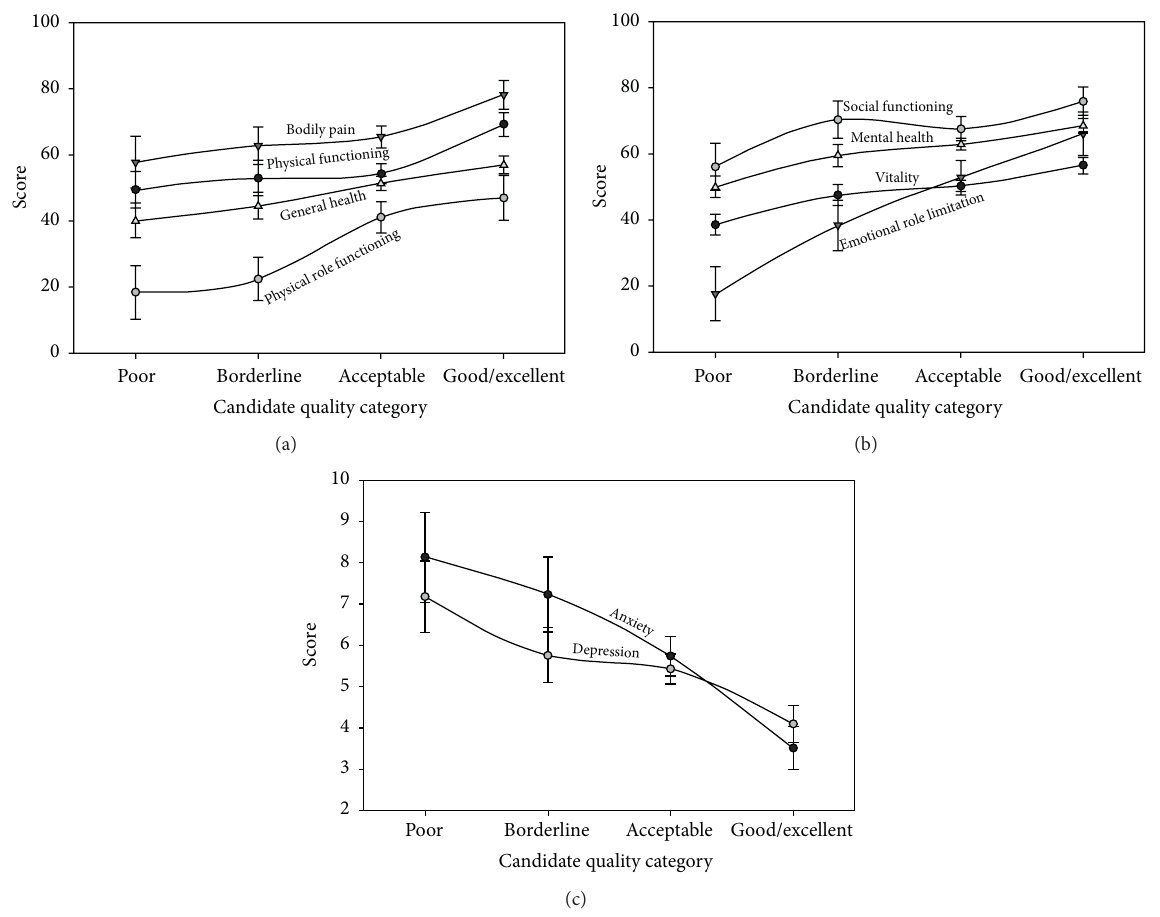
Figure 1: Association between liver transplant candidate quality and Health-related quality of life (a, b) and between liver transplant candidate quality and anxiety and depression (c) . (a, b) Scores in SF-36 domains linearly increase when moving from poor to good/excellent candidate quality categories. Physical functioning ( 𝐹 = 7.287 , 𝑝 = 0.008 ), physical role functioning ( 𝐹 = 8.663 , 𝑝 = 0.004 ), bodily pain ( 𝐹 = 6.042 , 𝑝 = 0.015 ), general health ( 𝐹 = 11.478 , 𝑝 = 0.001 ), vitality ( 𝐹 = 17.616 , 𝑝 < 0.001 ), social functioning ( 𝐹 = 4.455 , 𝑝 = 0.036 ), emotional role functioning ( 𝐹 = 18.148 , 𝑝 < 0.001 ), and mental health ( 𝐹 = 19.341 , 𝑝 < 0.001 ). (c) HADS anxiety and depression scores linearly decrease when moving from poor to good/excellent candidate quality categories. Anxiety ( 𝐹 = 17.526 , 𝑝 < 0.001 ), depression ( 𝐹 = 11.673 , 𝑝 = 0.001 ). Abbreviations: SF-36, Short-Form health survey; HADS, Hospital Anxiety and Depression